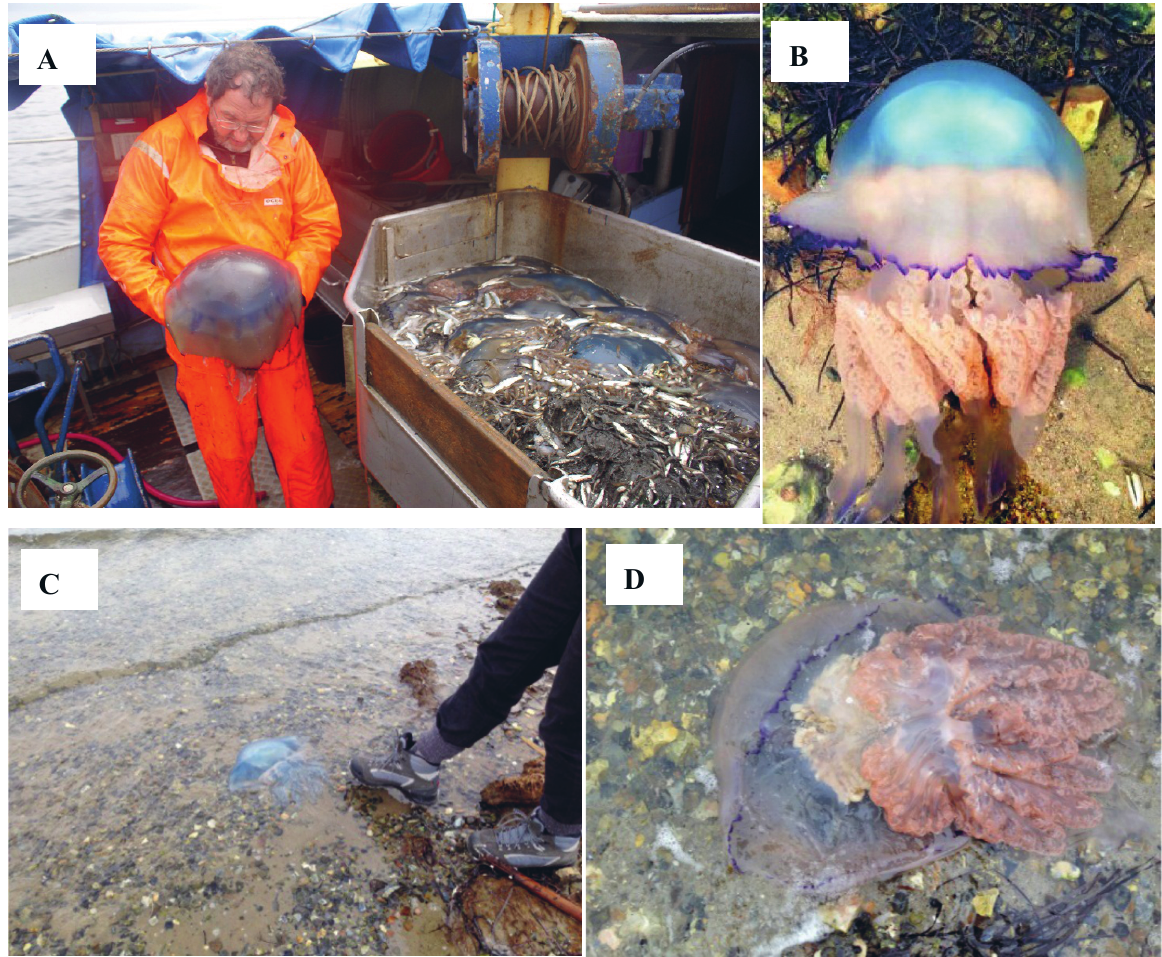
Figure 5. Jellyfish from the North Sea observed in Limfjorden. ( A ) Rhizostoma octopus caught in Limfjorden (Risgårde Bredning) 17 September 2012 by DTU-Aqua during a fisheries monitoring survey. Photo: Erik Hoffmann; ( B ) Stranded R. octopus on the beach near Glyngøre, Limfjorden, on 7 September 2013. Note the characteristic jagged purple bell edge and reddish oral arms. Photo: Joan Thora E. Laurberg. ( C , D ) R. octopus stranded on the beach (Lysen Bredning, near Salling Sund, Limfjorden) 22 September 2013. Photo: Hans Ulrik